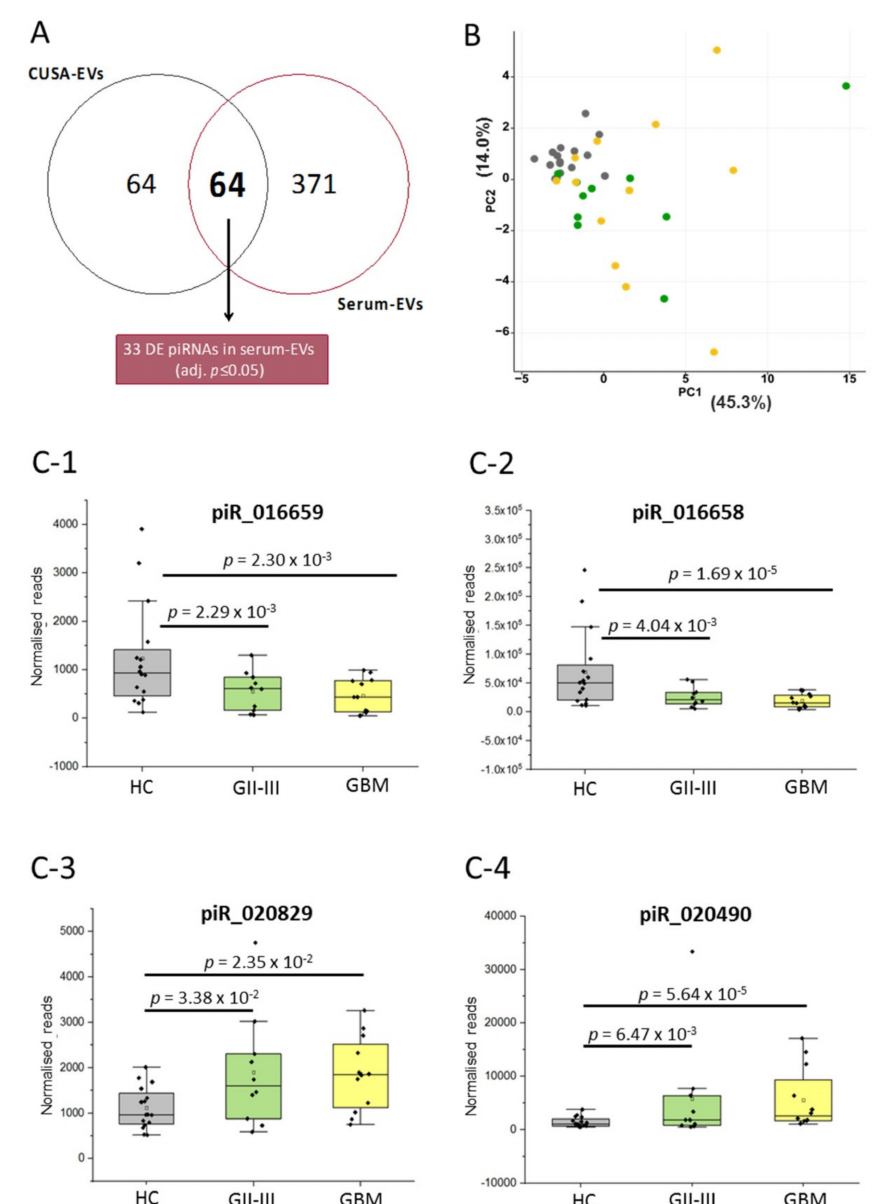
Figure 4. piRNA species in glioma EVs captured from CUSA fluid and serum. ( A ) Venn diagram showing the overlap of piRNAs detected in CUSA-EVs (average UMI count ≥ 10 in both GBM and GII-III) and serum-EVs (average read count ≥ 5 in at least two of three cohorts [GBM, GII-III and healthy controls; HC]). The Oasis 2.0 analytical pipeline was used to perform di ff erential expression analyses and identified 33 significant piRNAs in serum-EVs (adjusted p ≤ 0.05; pairwise comparisons). ( B ) PCA plot shows the ability of 33 significant piRNA species to cluster serum-EV profiles from GBM ( yellow, n = 12), GII-III ( green , n = 10) and HC ( grey , n = 16) specimens; the proportion of the variance is explained by PC1 ( x -axis) = 45.3% and PC2 ( y -axis) = 14.0%. ( C ) Significant CUSA-EV piRNAs are also significant in circulating serum-EVs. The box-plots show ( C-1 ) piR_016659, ( C-2 ) piR_016658, ( C-3 ) piR_020829 and ( C-4 ) piR_020490 serum-EV expression levels for HCs ( n = 16, grey), GII-III ( n = 10, green) and GBM ( n = 12, yellow). The normalized piRNA reads for each individual patient and denoted by a black dot. The upper error bars signify the 90 th percentile and lower error bars represent the 10th percentile, the middle line represents the median and the open square signifies the